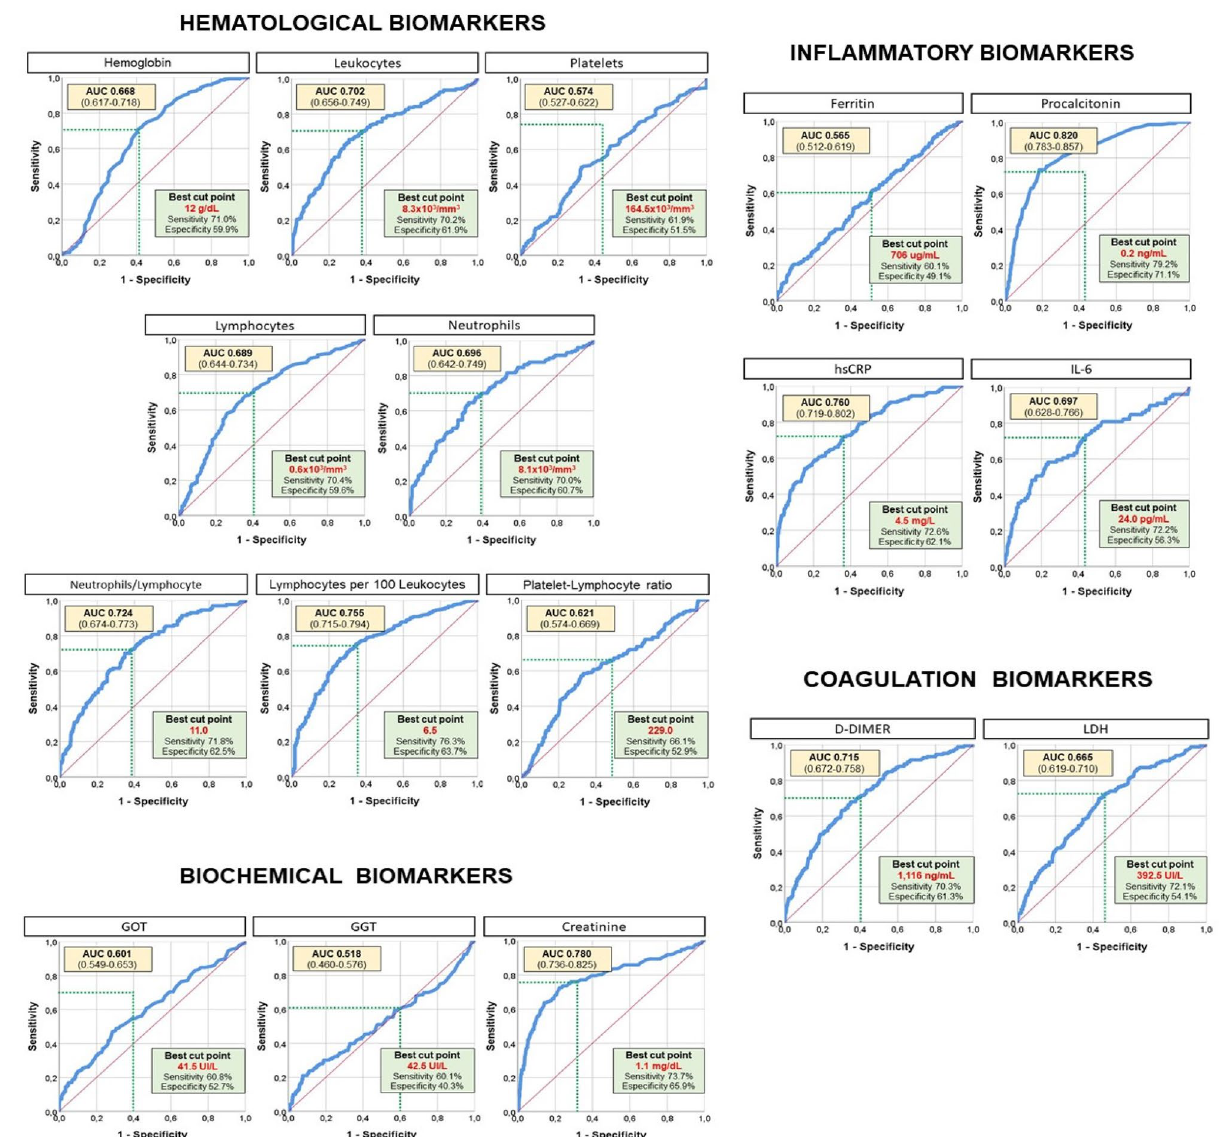
Figure 1. Discrimination of biomarkers. AUC area under the curve for each different